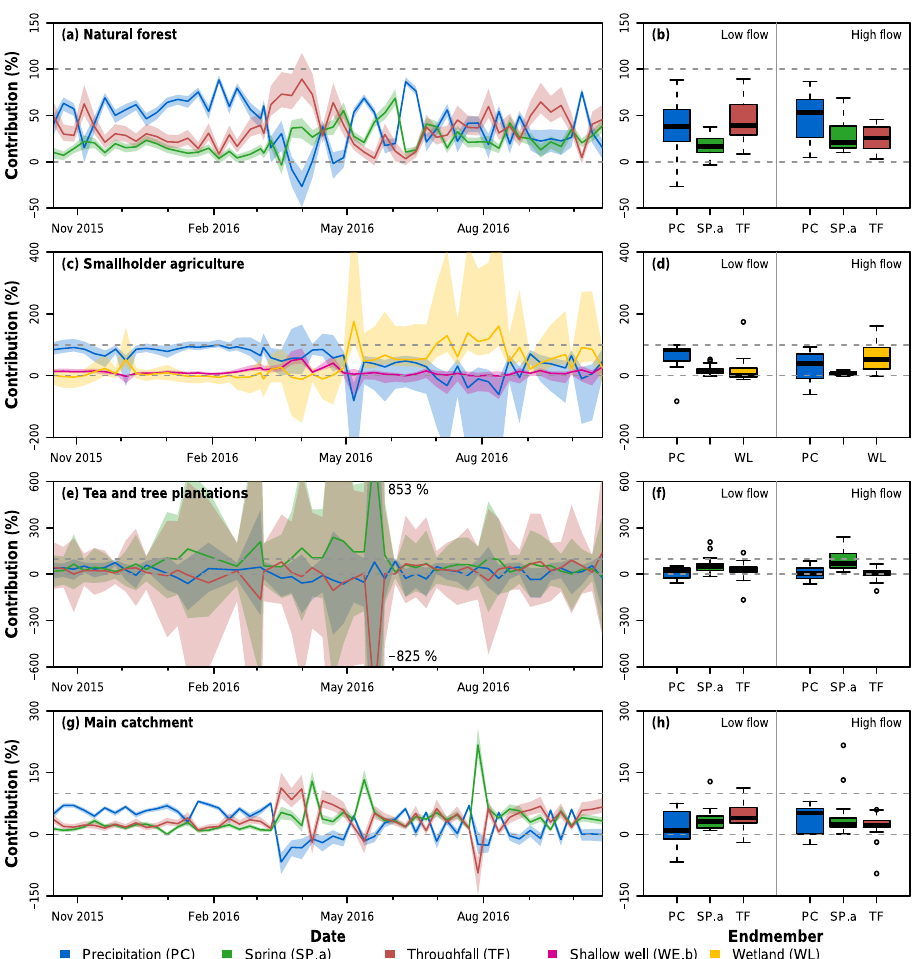
Figure 5. Contribution of selected endmembers to streamflow for the (a–b) natural forest (NF), (c–d) smallholder agriculture (SHA), and (e–f) tea and tea plantation (TTP) sub-catchments and (g–h) the main catchment (OUT) between 15 October 2015 and 21 October 2016 in the South-West Mau, Kenya. The grey dashed lines indicate the realistic range of endmember contributions. Shaded areas represent the 5th to 95th percentile of 10000 Monte Carlo simulations of the EMMA, while the line represents the median endmember contribution. The thick line in the box plots represents the median endmember contribution, separated by flow condition. The box shows the interquartile range and the whiskers the minimum and maximum values within 1.5 times the interquartile range. Outliers are indicated with open